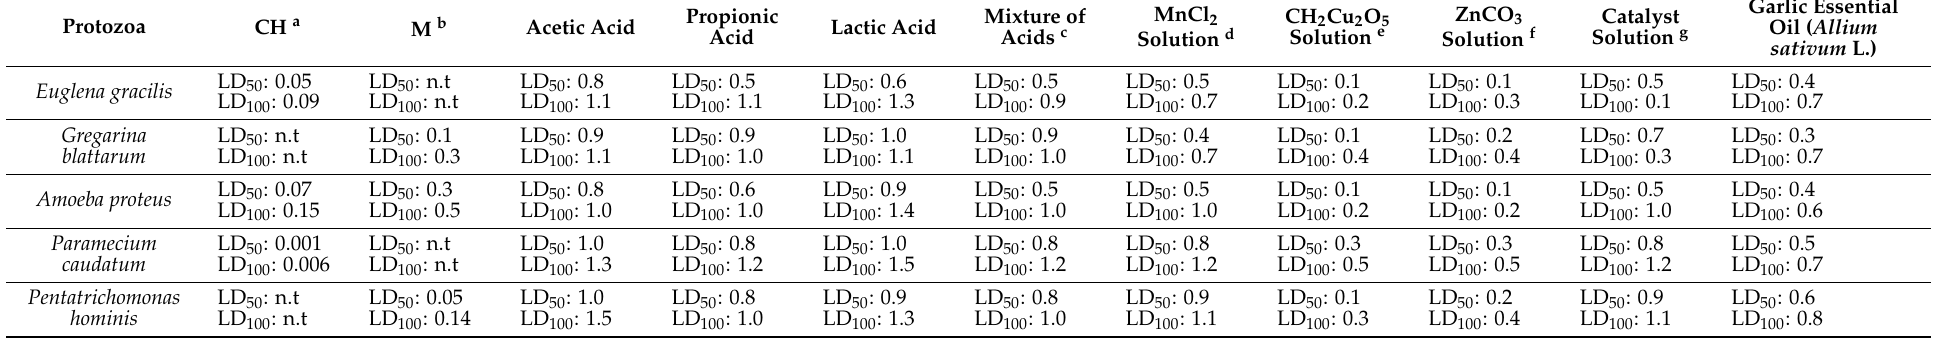
Table 4. LD 50 , LD 100 values [%] of garlic essential oil ( Allium sativum L.) and the components used in the study. Propionic Protozoa M b Acetic Acid Acid